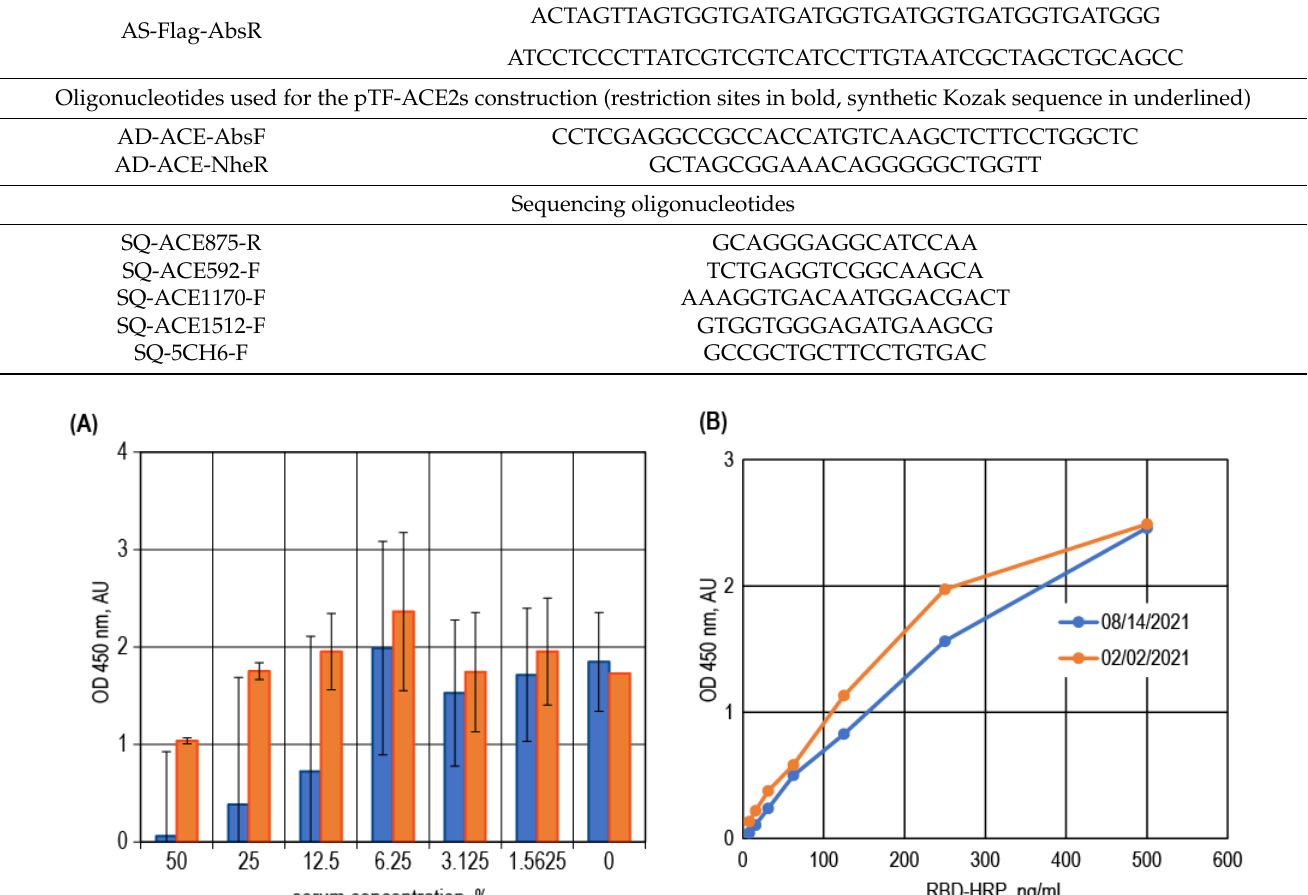
Figure A1. Technical properties of ACE2-coated microplate and ACE2-HRP conjugate. ( A ) Direct readings of the sVNT test, performed for two donor samples in the ACE2:RBD-HRP format, error bars represent standard deviations, n = 3; ( B ) Calibration curves, performed for the RBD:ACE2-HRP test format, analysis dates are shown on the panel, n = 2.